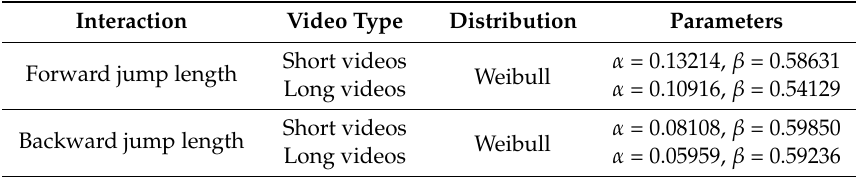
Table 1. Jump length characterization.